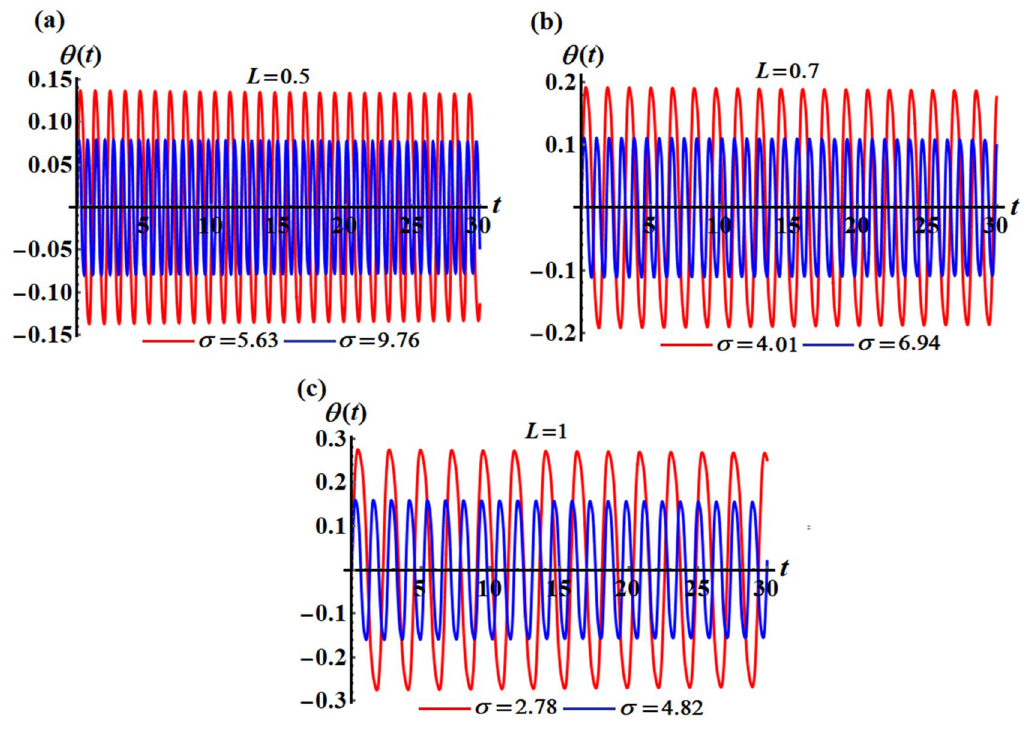
Figure 2. Represents the time dependent of the solution θ( t ) at: ( a ) L = 0.5, σ( = 5.63, 9.76 ) , ( b ) L = 0.7, σ( = 4.01, 6.94 ) , and ( c ) L = 1, σ( = 2.78, 4.82 )